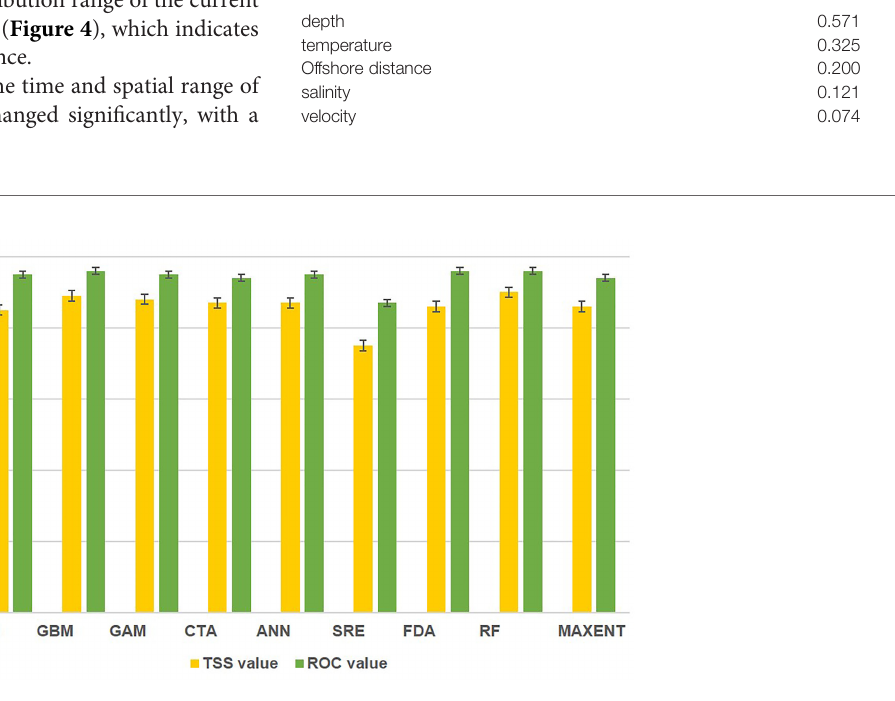
FIGURE 2 | Model accuracy evaluation.